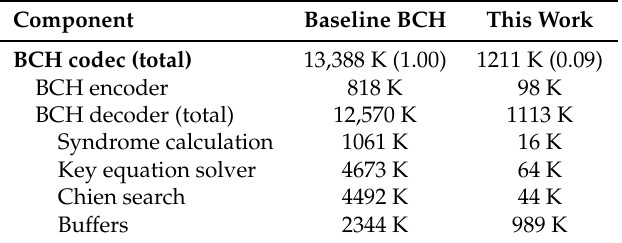
Figure 9. The die-photo of the prototype baseband processor. Table 1. Hardware complexity comparison of BCH codec